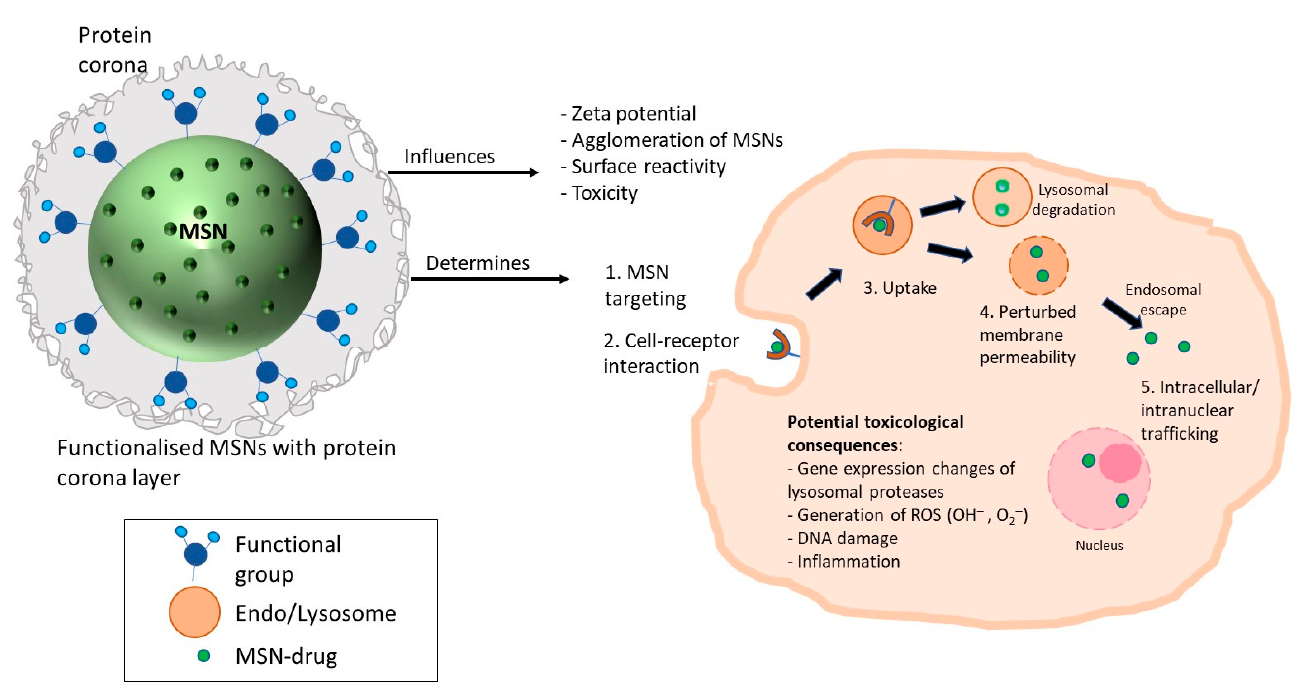
Figure 11. Protein corona can influence physicochemical characteristics of MSNs. This may determine MSN targeting, receptor recognition, uptake, intracellular and/or intranuclear trafficking, and potential toxicological consequences. Supplementary Materials: The following are available online at www.mdpi.com/xxx/s1: Table S1. Mean ranks of study groups; Table S2. Post ‐ hoc test of study groups; Table S3. Normality tests for different MSN sizes; Table S4. Normality tests for different viability assay method groups; Table S5. Normality tests for different incubation times; Table S6. Normality tests for different MSN zeta ‐ potential; Table S7. Normality tests for different functionalisation types; Table S8. Normality test for cell types’ viability; Table S9. Mean ranks of MSN size groups; Table S10. Post ‐ hoc test of MSN size groups; Table S11. Mean ranks of viability assay method groups; Table S12. Post ‐ hoc test of viability assay method groups; Table S13. Mean ranks of incubation time groups; Table S14. Post ‐ hoc test of incubation time groups; Table S15. Mean ranks of MSN zeta ‐ potential groups; Table S16. Post ‐ hoc test of MSNs’ zeta ‐ potential groups; Table S17. Shapiro Wilk’s test of normality for functionalised and non ‐ functionalised MSN groups in the dataset; Table S18. Mean ranks of functionalisation groups; Table S19. Post ‐ hoc test of functionalisation groups; Table S20. Mean ranks of cell ‐ type groups; Table S21. Post ‐ hoc test of cell type groups.